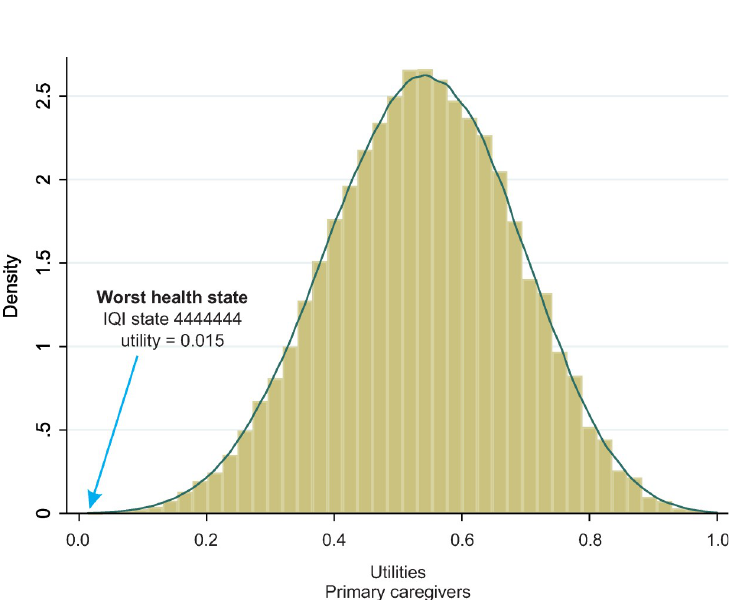
Fig 4. Estimated health-state utilities obtained for the primary caregivers (discrete choice task) normalized for the location of death (based on values derived from task with death by the general population).